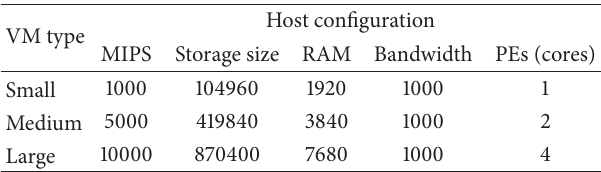
Table 2: Host configuration with VM